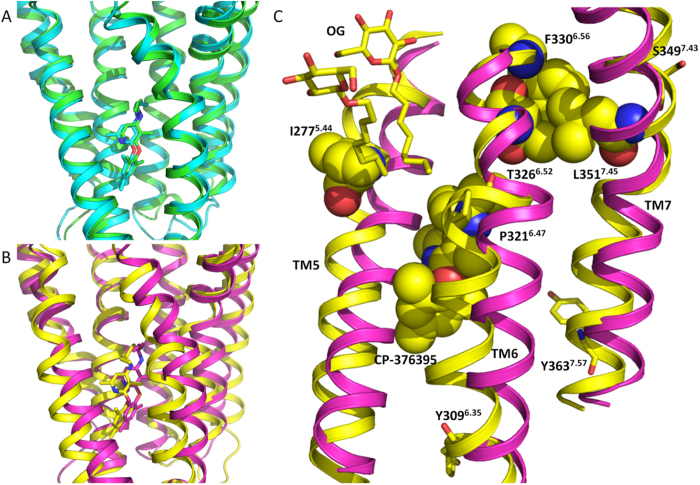
CRF1R WT and StaR molecular dynamics analysis.CRF1R structural superimposition of the starting and final conformation (after 100 ns explicit all-atom MD in an OG-water-micelle environment) for the StaR (panel (A)) and WT (panel (B)). Only the helical bundle backbone is shown as ribbon together with the ligand CP-376395. The initial conformation is coloured in green and magenta respectively for the StaR and the WT, while the final state is respectively in cyan and yellow. (panel (C)) Molecular destabilizing effects at the end of the CRF1R WT MD simulation (in yellow) of the residues I2775.44, Y3096.35, F3306.56 and Y3637.57 (all mutated to Ala in the StaR receptor). For clarity only TM5, TM6 and TM7 are shown. The backbone of the starting conformation is included in magenta as ribbon. I2775.44, F3306.56, T3266.52, L3517.45 and the ligand CP-376395 are shown as space filling, while Y3096.35, Y3637.57, P3216.47, S3497.43 and 2 OG molecules in stick representation.